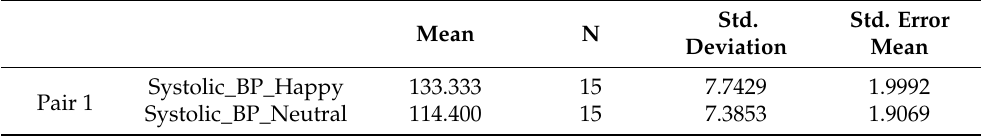
Table 7. Paired samples statistics for heart rate (happy to neutral state).